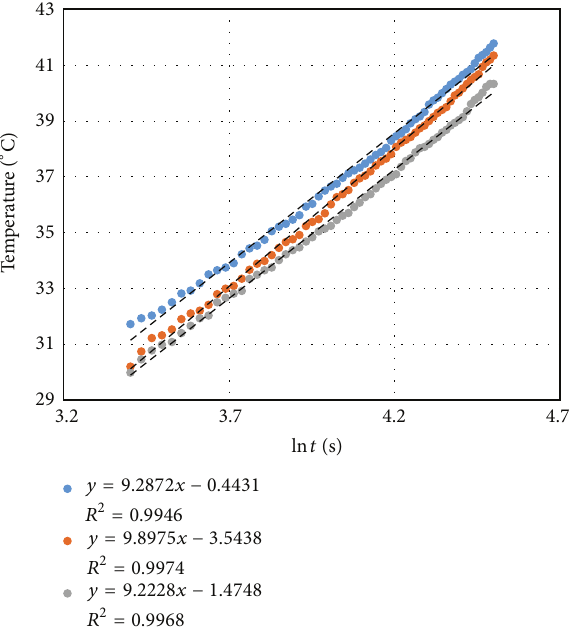
Figure 9: Evaluation of thermal conductivities of aerogel material by transient hot-wire